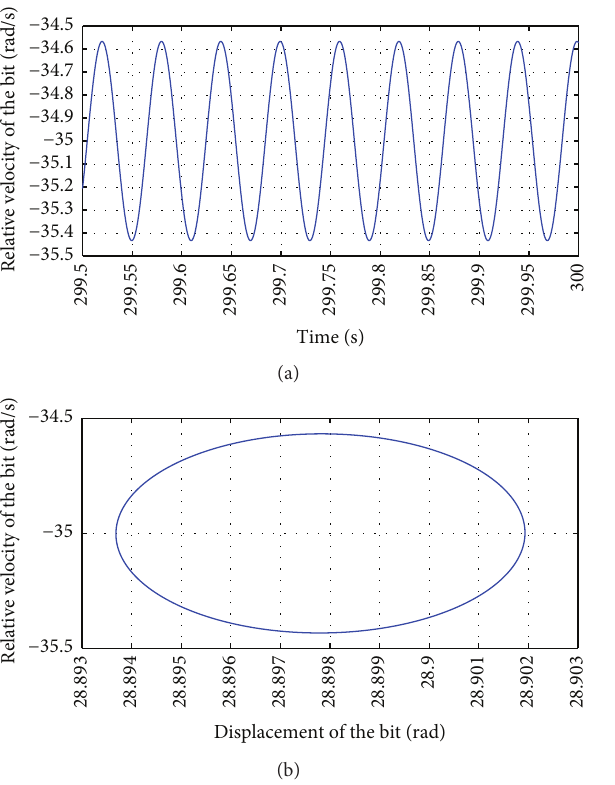
Figure 5: Mean response without stick-slip: (a) time history; (b) phase